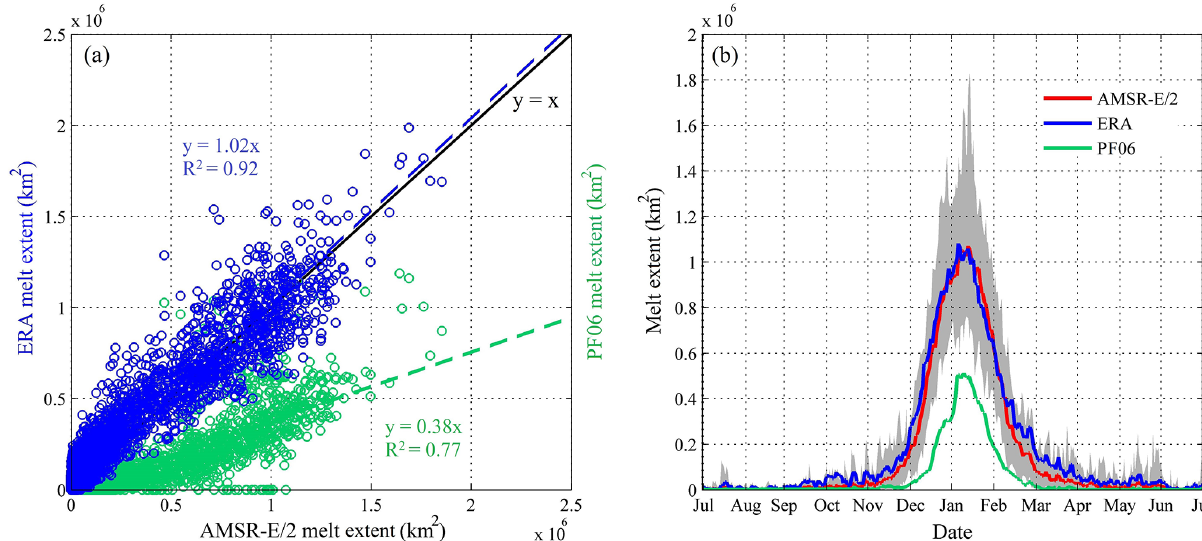
Figure 10. Comparison of AIS melt extent derived by AMSR-E/2, ERA-Interim and PF06 from 2002 to 2017. (a) Scatter plot of daily melt extent; blue circles indicate AMSR-E/2 vs. ERA-Interim and green circles indicate AMSR-E/2 vs. PF06. (b) Daily mean melt extent derived by AMSR-E/2 (red line), ERA-Interim (blue line) and PF06 (green line); grey shading indicates the daily maximum and minimum melt extent detected by